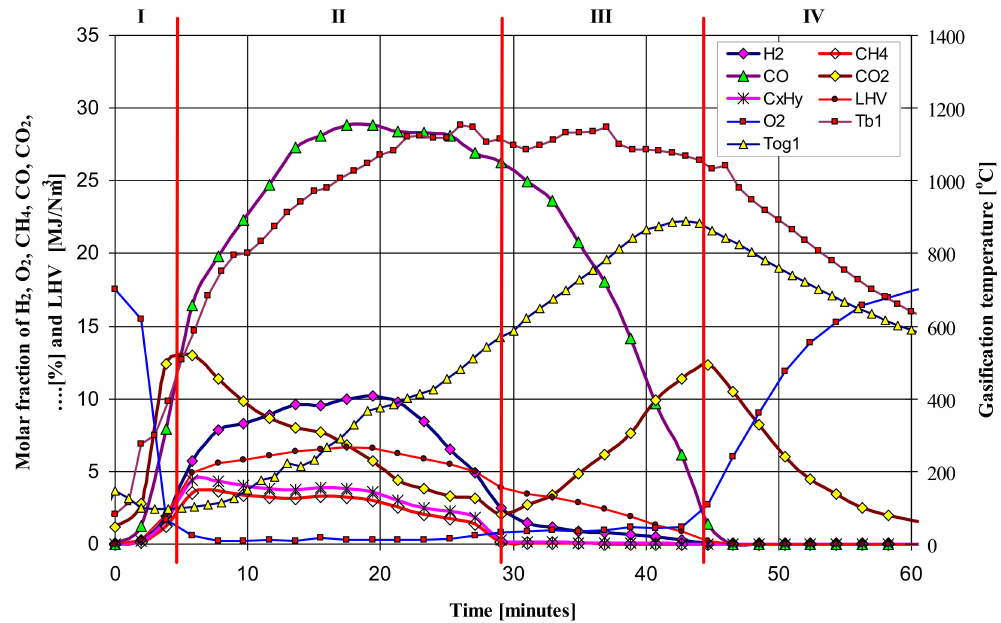
Figure 3. Changes of the fuel gas composition (H 2 , CO, CO 2 , CH 4 , C m H n , O 2 ), LHV, gasifier bed temperature (T b1 ) and the exiting fuel gas temperature (T og1 ), versus gasification process time. Feed gas conditions: 50 Nm 3 /h of air preheated to 350 ◦ C (gasification of 20 kg of wood pellets 12 mm).